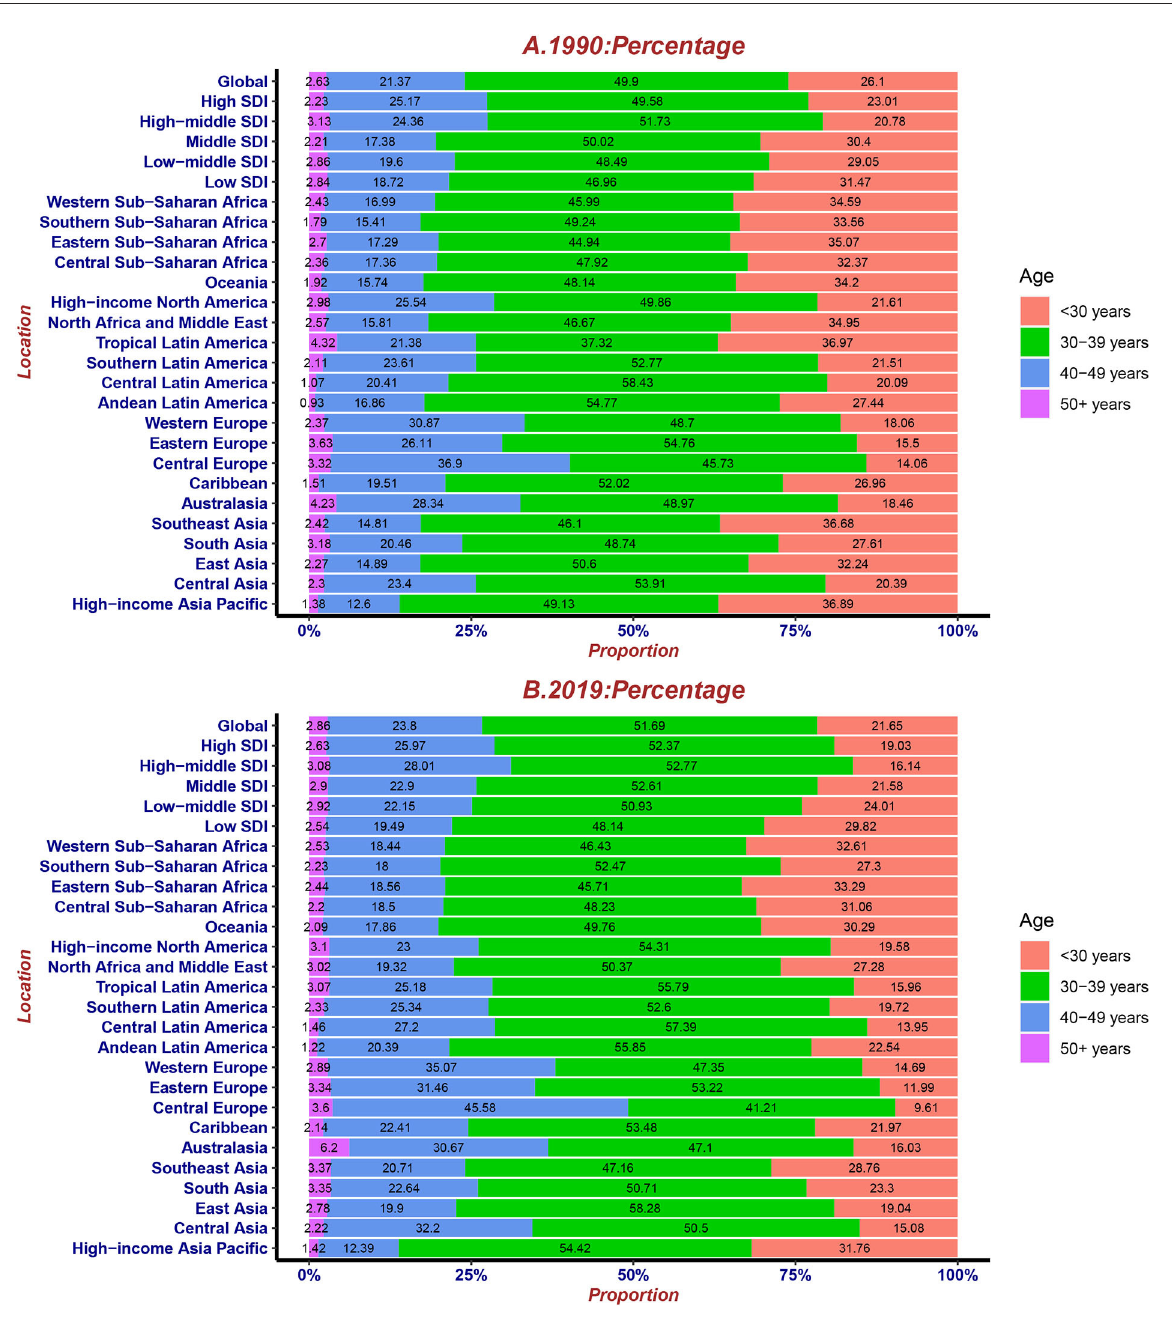
FIGURE7 The proportion of four age groups for UFs incident cases globally and by region, contrasted in 1990 (A) and 2019 (B)